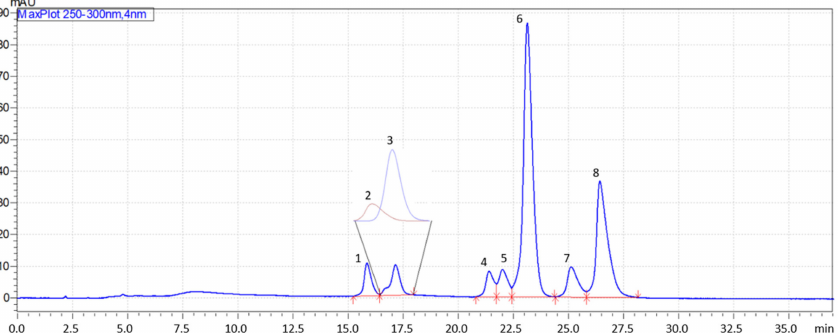
Figure 8. Exemplary chromatogram of optimized gradient separation on Diol–P–C18 stationary phase; linear gradient from 0% to 50% of ACN in 10 mM ammonium acetate; 1–atenolol,